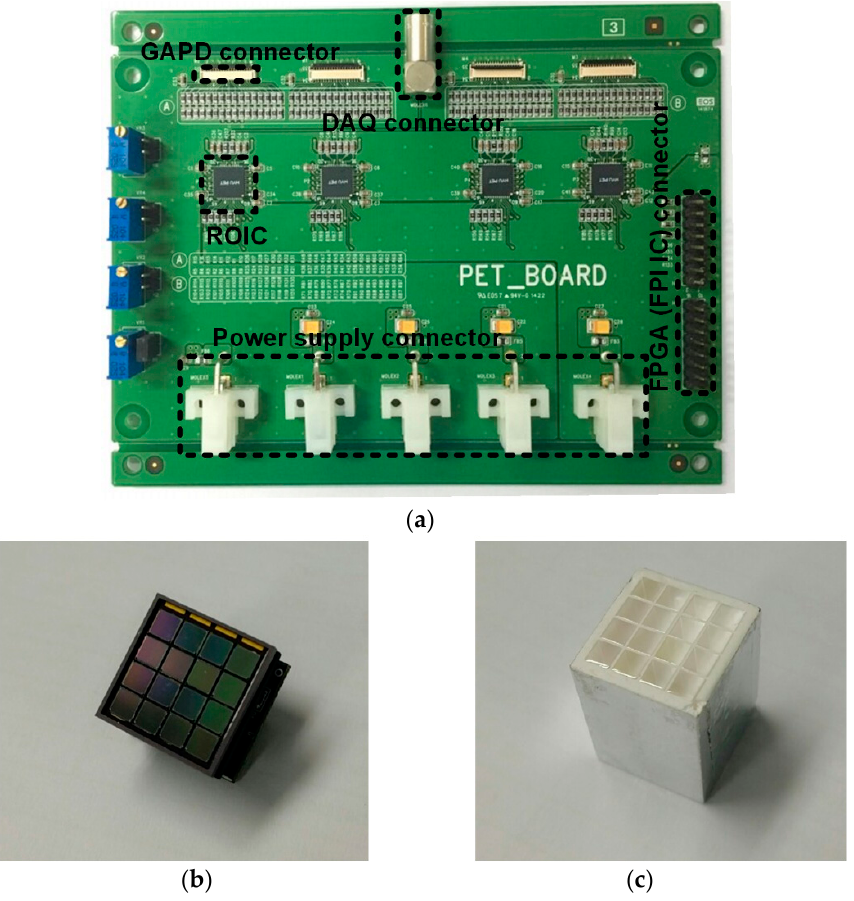
Figure 9. Photograph of a ( a ) test board of the ASP block, ( b ) 4 × 4 Geiger-mode avalanche photodiode (GAPD) array, and ( c ) 4 × 4 lutetium-yttrium oxyorthosilicate (LYSO)